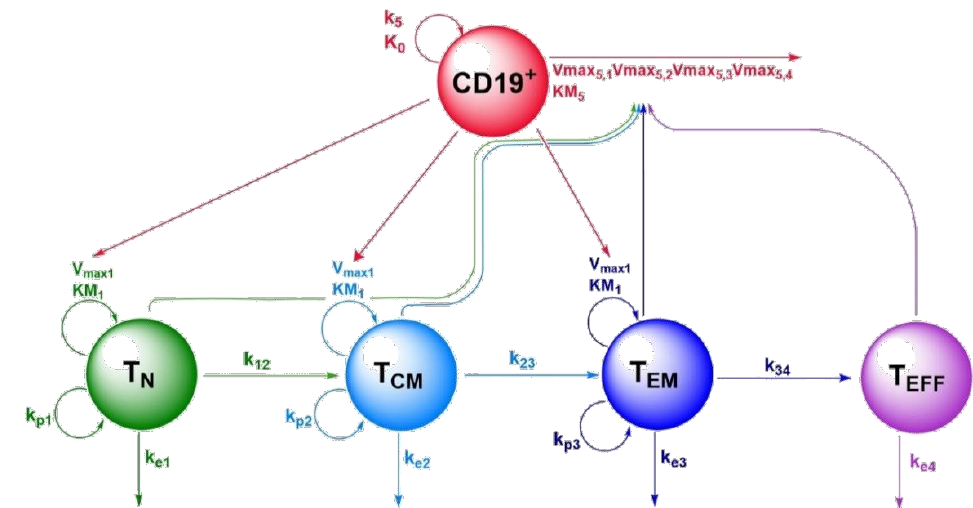
Figure 1. Schematic representation of the CD19-specific CAR-T cell population quantitative systems pharmacology model, describing kinetics and dynamics of the four CAR-T cell phenotypes and CD19 + tumor metabolic tumor volume. Legend: Non-red arrows pointing to the right describe differentiation processes. Non-red downward arrows represent cell death processes. Circular arrows represent proliferation processes. The red arrow pointing to the right represents CD19 + tumor death. Arrows pointing to parameter names indicate a positive impact on this parameter by the species of which the arrow is originating from. Abbreviations—T N : naïve CAR-T cells; T CM : central memory CAR-T cells; T EM : effector memory CAR-T cells; T Eff : effector CAR-T cells; CD19 + : CD19 + metabolic tumor volume; k 12 : rate constant for differentiation of T N to T CM ; k 23 : rate constant for differentiation of T CM to T EM ; k 34 : rate constant for differentiation of T EM to T Eff ; ke 1 : death rate constant for T N ; ke 2 : death rate constant for T CM ; ke 3 : death rate constant for T EM ; ke 4 : death rate constant for T Eff ; kp 1 : homeostatic proliferation rate constant for T N ; kp 2 : homeostatic proliferation rate constant for T CM ; kp 3 : homeostatic proliferation rate constant for T EM ; V max1 : maximum expansion rate per mL tumor volume of T N, T CM and T EM upon tumor contact; KM 1 : T N , T CM and T EM concentration at half-maximum expansion of T N , T CM and T EM ; V max5,1 : maximum killing rate of metabolic tumor volume by T N ; V max5,2 maximum killing rate of metabolic tumor volume by T CM ; V max5,3 : maximum killing rate of metabolic tumor volume by T EM ; V max5,4 : maximum killing rate of metabolic tumor volume by T Eff ; KM 5 : metabolic tumor volume at half-maximum killing rate; k 5 : proliferation rate constant of metabolic tumor volume; K 0 : maximum tumor volume observable (tumor carrying capacity).